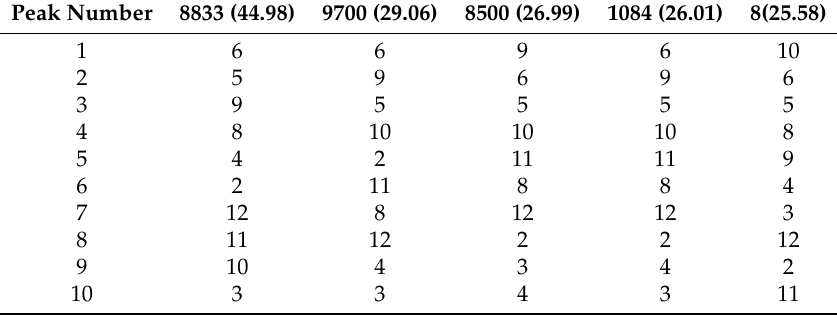
Table 2. Z-DNA phosphorus atoms found by SHELXD for tries with varying